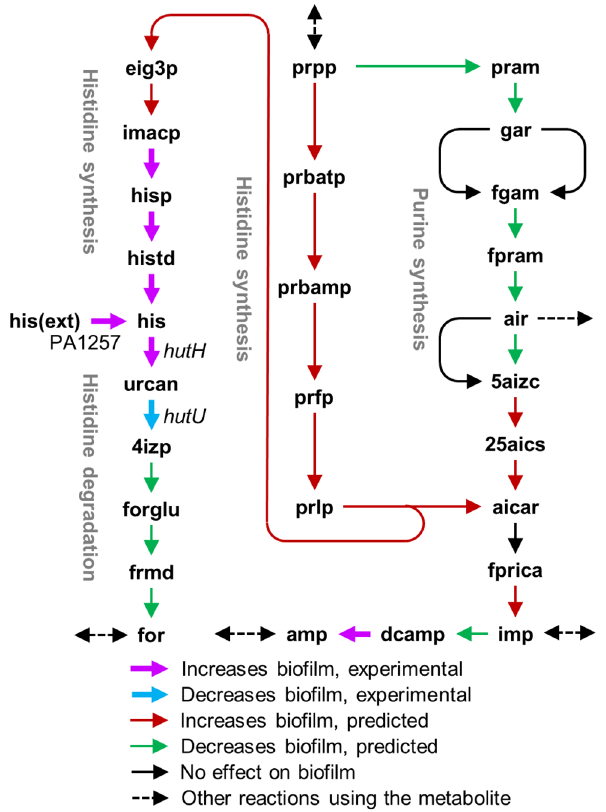
Fig 1. Alteration of biofilm formation by different reaction inhibitions in the histidine and purine synthesis pathways. Reactions indicated with magenta and cyan arrows were experimentally identified by Musken et al. [22]. We predicted reactions indicated with red and green arrows. Abbreviations: aicar, 5-phosphoribosyl-4-carbamoyl-5-aminoimidazole; prpp, 5-phosphoribosyl diphosphate; amp, adenylate. See S1 Supporting Information for the definition of the remaining of the